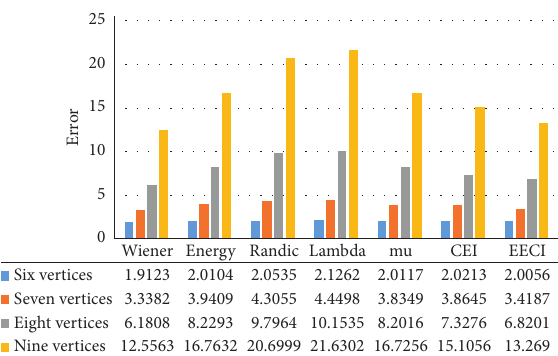
Figure 1: Errors between graph edit distance and similarity measures based on Wiener index (Wiener), graph energy (Energy), Randi´c index (Randic), the largest adjacent eigenvalue (lambda), the largest Laplacian eigenvalue (mu), connective eccentricity index (CEI), and Ediz eccentric connectivity index (EECI). The X -axis represents different topological indices. The Y -axis represents the distributions of error values between graph edit distance and similarity